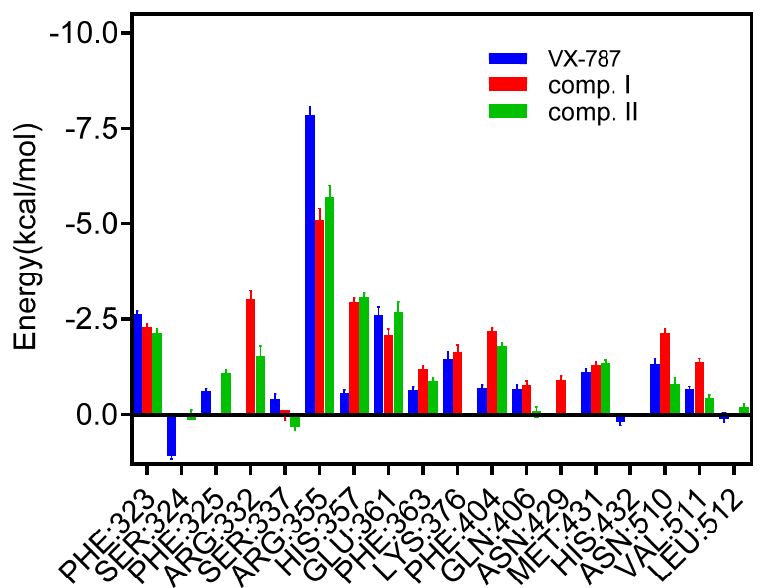
Figure 9. Per − residue binding energy decomposition of VX-787, comp. I , and comp. II .